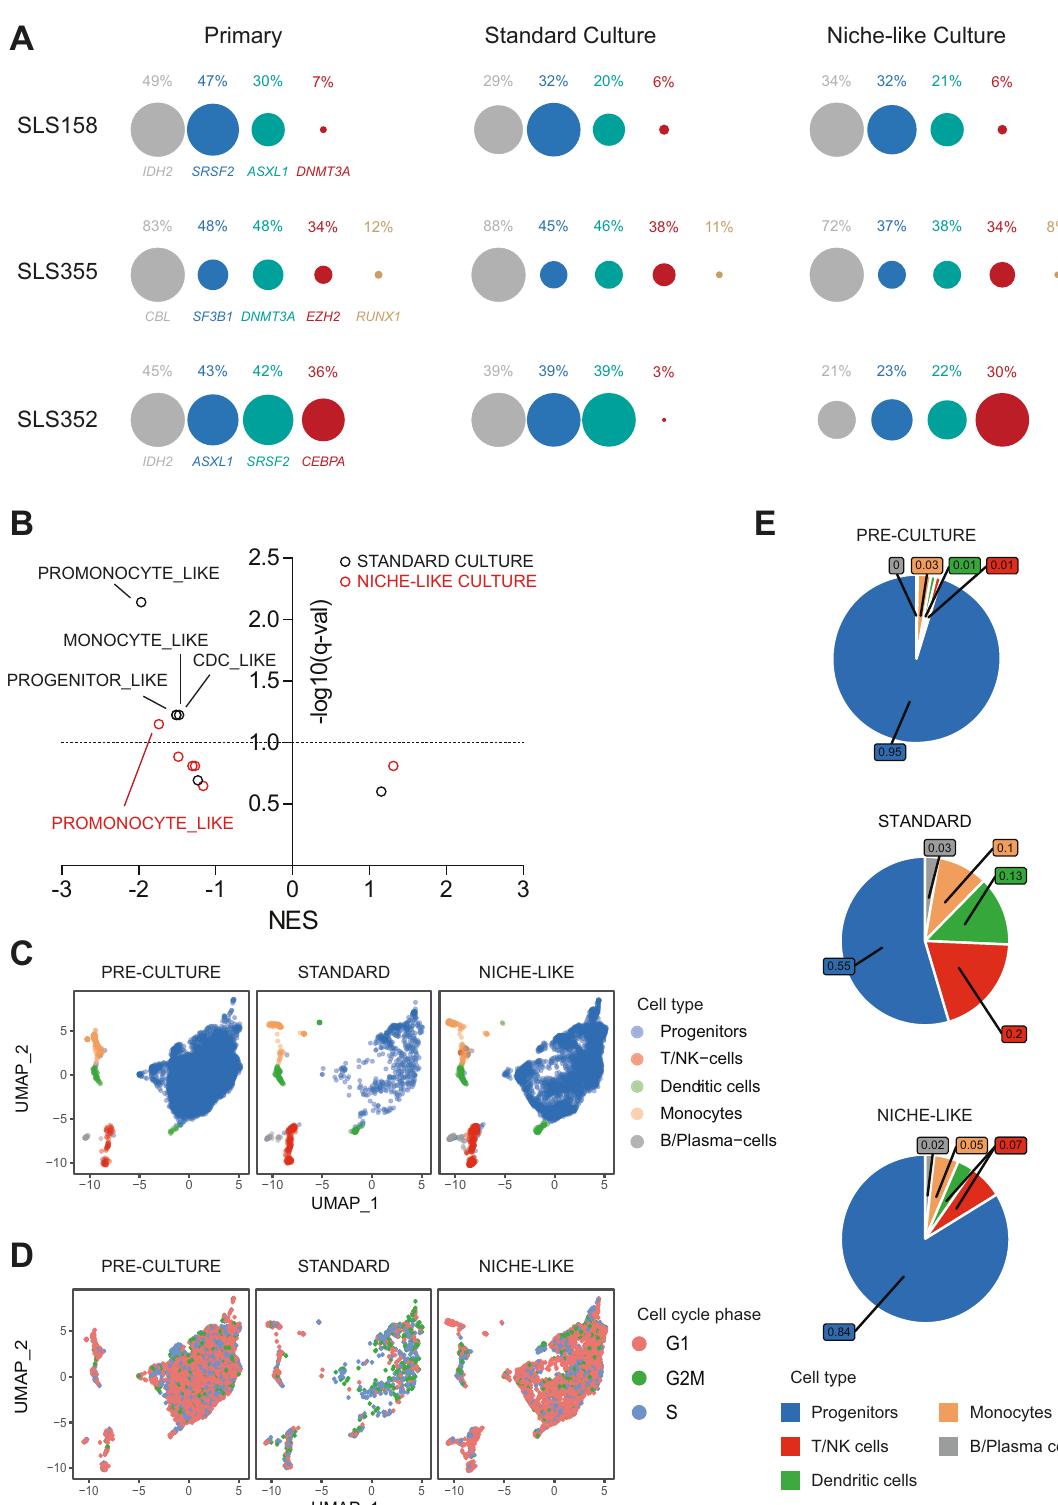
a 6-hour culture and compared the transcriptome of cells exposed to niche-like versus standard culture conditions in 4 patients. When inspecting the gene expression signatures of leukemic cells reported at the single-cell level (Supplementary Table 9) [13], both culture conditions depleted the promonocyte-like signature but